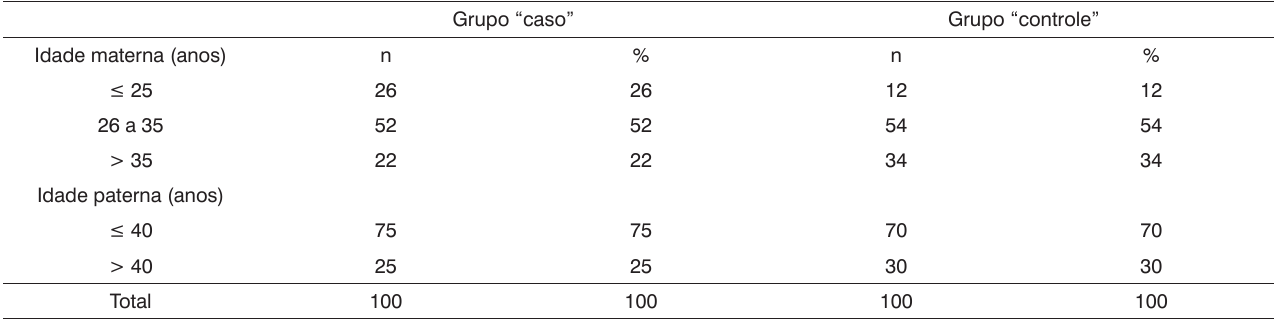
Tabela 3. Distribuição da idade materna e paterna nos grupos “caso” e “controle”. Grupo “caso” Grupo “controle”